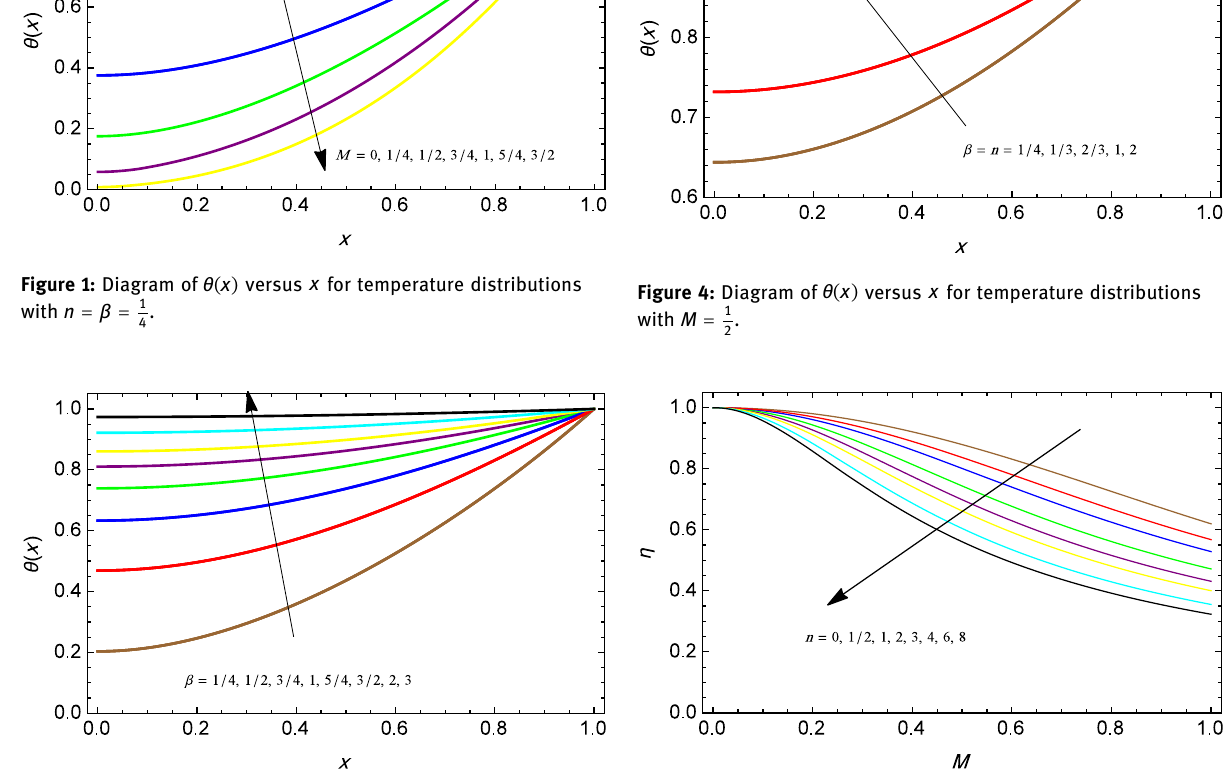
Figure 5: Diagram of fi n e ffi ciency versus M for di ff erent n with β 1 = 2